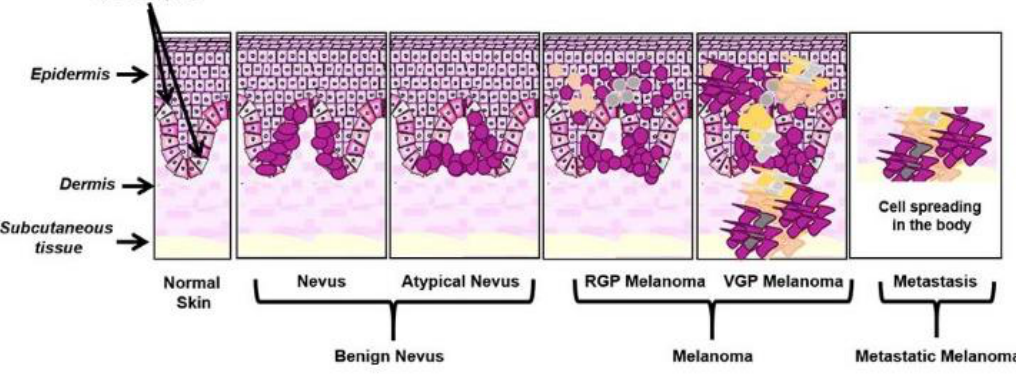
Figure 1. Schematic representation of melanoma onset and progression. Melanoma onset and progression described in the text was illustrated, underlining its clonal evolution, phenotype switching, and high heterogeneity [10].